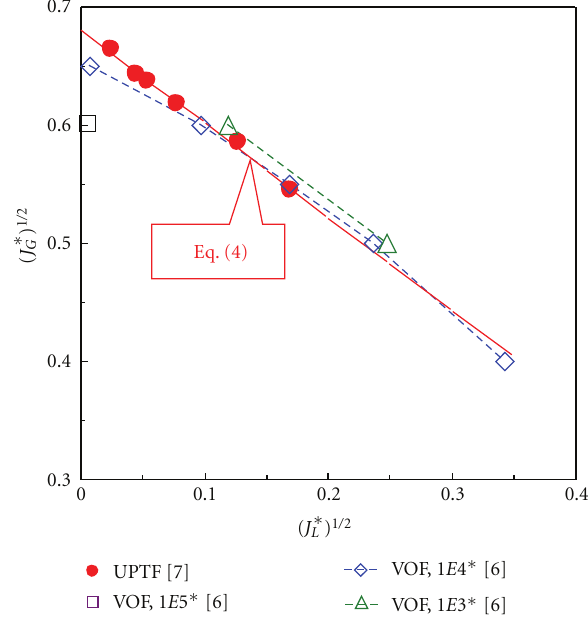
Figure 4: CCFL characteristics at 1.5MPa ( ∗ maximum turbulent viscosity